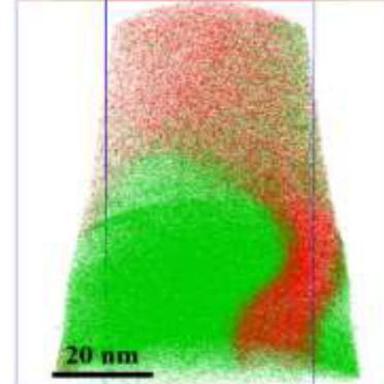
(a) APT data set showing the 3D distribution of the two phases in the inner oxide layer (Cr in red and Ni in green); (b) spatial distribution of O, Cr, Fe, and Ni in separate data sets; (c) concentration profiles across the oxide-metal phases interface.